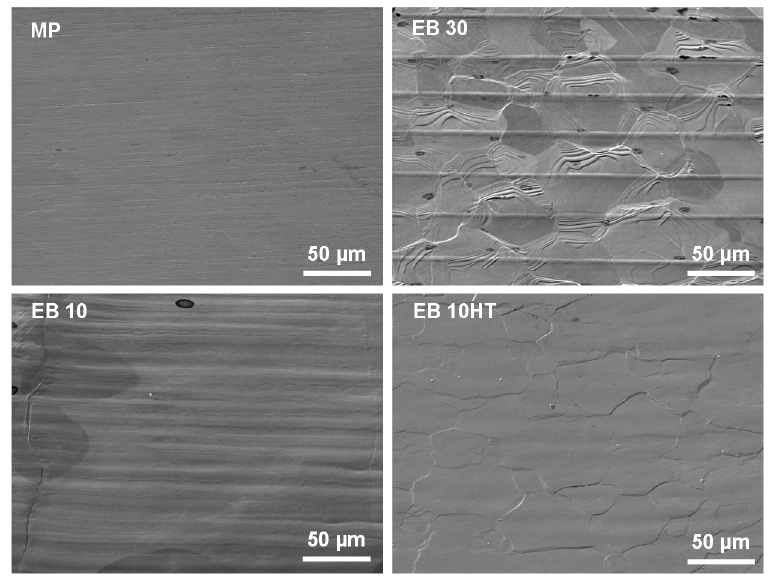
Figure 1. FESEM observations of the studied surfaces: mechanically polished (MP), e-beam structured with grooves 30 or 10 µm large (EB30, EB10) and EB10 thermally treated.